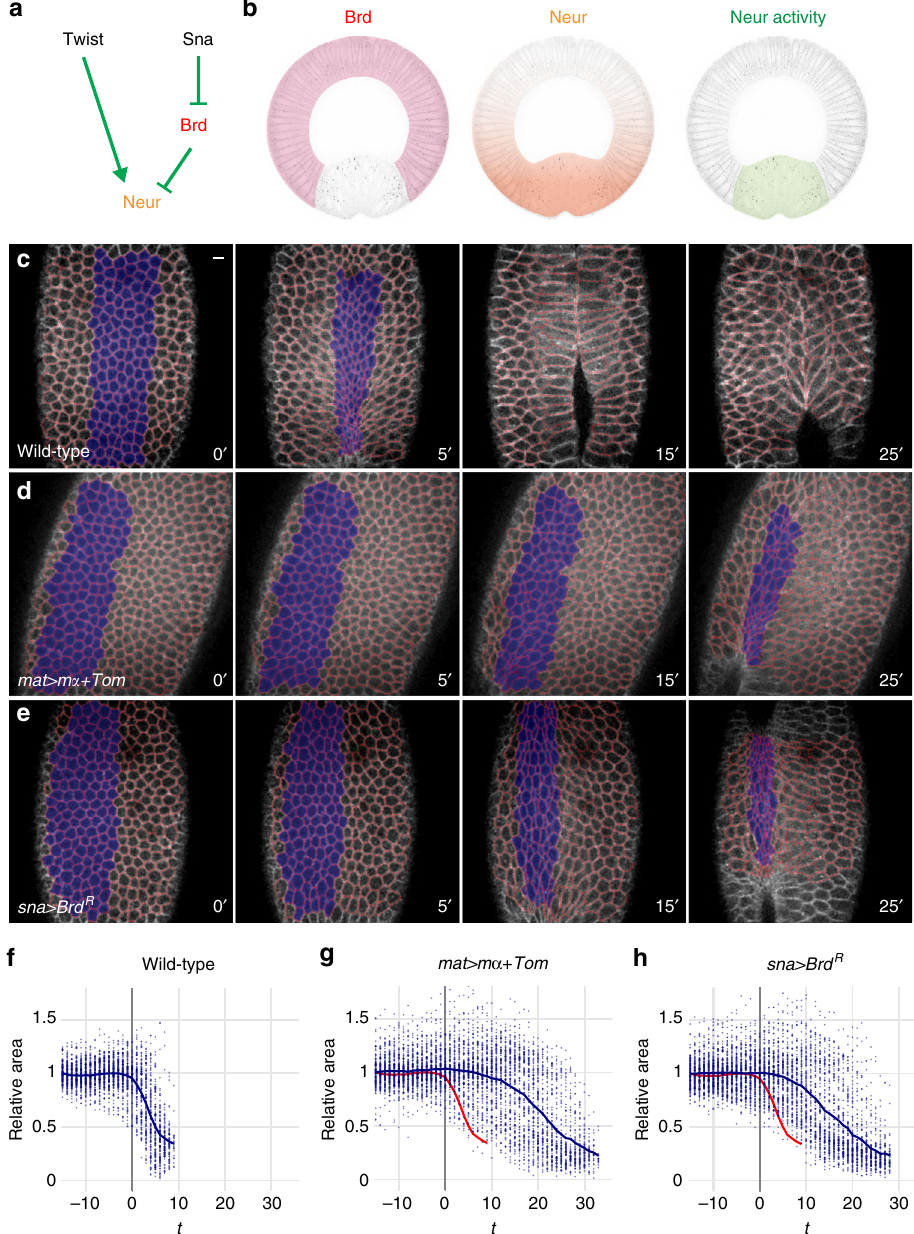
Fig. 1 Ectopic Brd inhibits apical constriction. a Genetic control of Neur activity. Twist positively regulates neur gene expression in the mesoderm, whereas Snail represses the expression of the Brd family genes. Brd proteins antagonize Neur. b Brd activity (pink) is restricted to the ectoderm by Snail. Inhibition of Neur (orange) by Brd restricts the activity of Neur (green) to the mesoderm. c – e Live imaging of wild-type ( c ), mat > m α + Tom ( d ), and sna > Brd R ( e ) embryos expressing MyoII-GFP (not shown) and Gap43-Cherry (white; tracking, red). Surface area values were measured for cells undergoing invagination (blue in c – e ). In this and all other fi gures, time ( t ) is in minute (min) after the onset of apical constriction (used as t = 0). f – h Analysis of apical constriction. Surface value distributions highlight the rapid and synchronous constriction of ventral cells in wild-type embryos ( f ). Each plot corresponds to a single embryo (see Supplementary Fig. 1c and d for the analysis of multiple embryos). Each dot represents one cell (mean values shown as a blue curve; control wild-type curve is red in ( g and h ). Maternal over-expression of m α and Tom ( g ) as well as zygotic expression of Brd R in the mesoderm ( h ) delayed furrow formation and led to the persistence of large non-constricting cells during furrow formation. In this and all other fi gures, scale bar is 10 μ